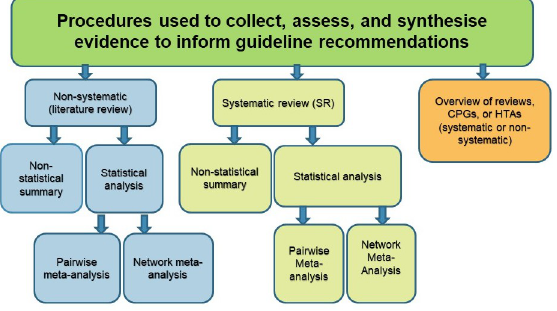
Fig 1. Procedures used to collect, assess, and synthesise evidence to inform guideline recommendations (i.e. systematic, non-systematic). Clinical practice guidelines can use a non-systematic or systematic process to collect, assess, and synthesise evidence to inform guideline recommendations. Guideline developers can conduct a (i) literature review (using non-systematic methods), (ii) systematic review (using systematic methods with inclusion